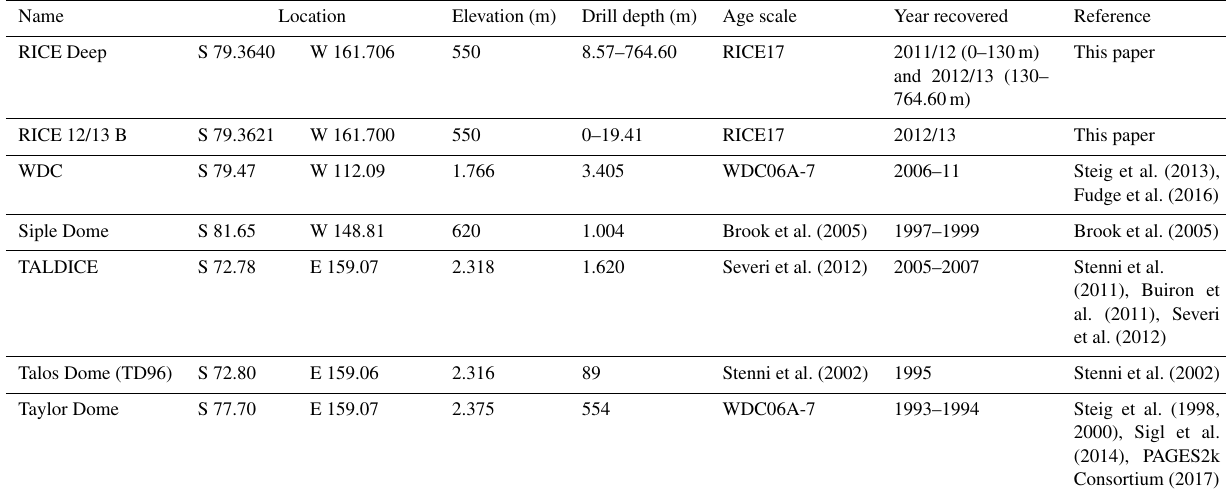
Table 1. Overview of ice core records used in this paper. Locations are presented in Fig. 1.